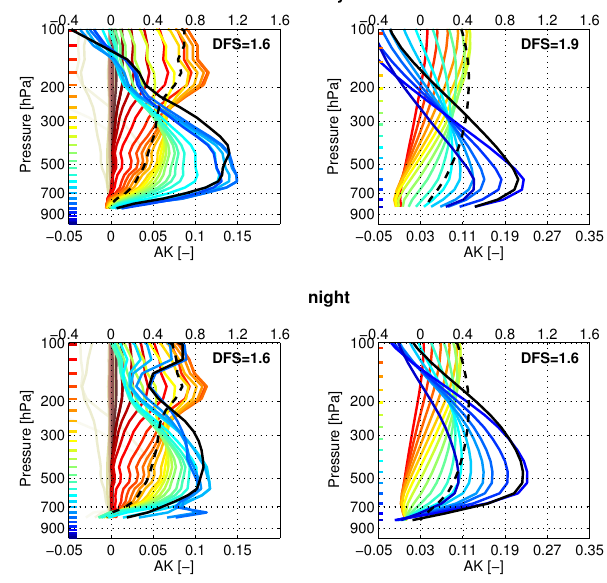
Fig. 2. SOFRID (left panel) and FORLI (right panel) averaging ker- nels (AK) (bottom x-axis, colour lines) and normalised averaging kernels of partial columns (top x-axis, black solid line: surface– 480hPa, black dashed line: 480–225hPa), for a daytime (top pan- els) and nighttime (bottom panels) retrieval of a IASI pixel near Frankfurt (50.1 ◦ N, 8.7 ◦ E) on 28 May 2008. The nominal height of each averaging kernel is marked by the horizontal tick with corre- sponding colour.